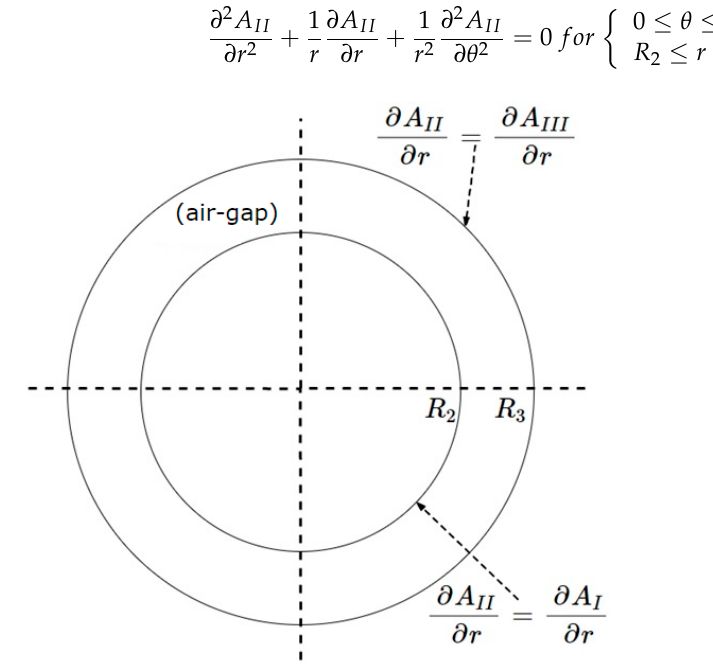
Figure 2. The air-gap subdomain and its boundary conditions.